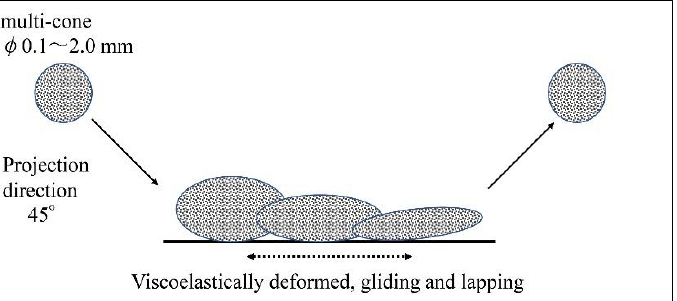
Figure 1. SBVM polishing image; polishing by shot blasting composite polishing media (multi-cone, Yamashita Works, Kyoto, Japan) consisting of viscoelastic food proteins containing water and diamond particles as abrasive grains.